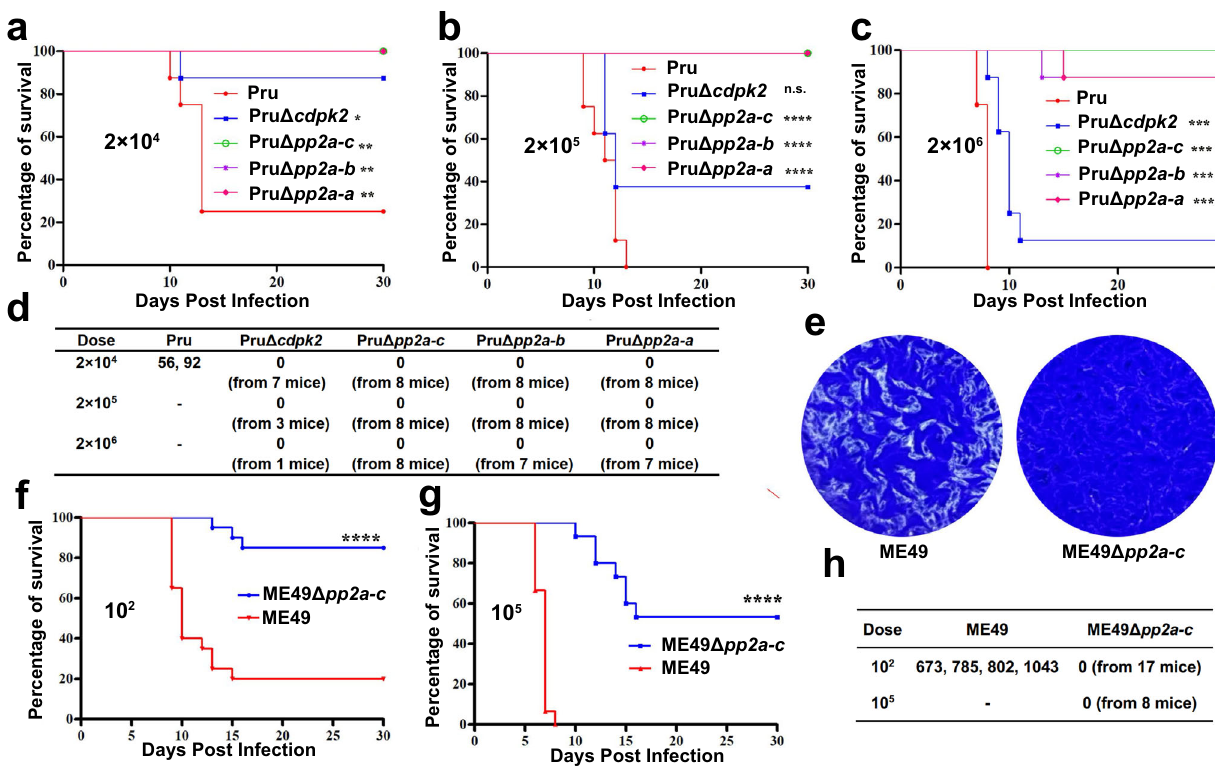
Fig. 4 | PP2A holoenzyme is necessary for formation of brain cysts in mice. a – c C57BL/6femalemicewereinfectedintraperitoneallywiththedesignateddoses oftheindicatedstrains( n =8mice/strain),andthesurvivalofmicewasmonitored for 30 days. Statistical signi fi cance tested by log rank Mantel-Cox test. Compared withPrustrain,for( a )group, *P value= 0.024(PruvsPru Δ cdpk2 ),** P value=0.003 (PruvsPru Δ pp2a-c ),** P value=0.003(PruvsPru Δ pp2a-b ),** P value=0.003(Pruvs Pru Δ pp2a-a );For( b )group,n.s.=notsigni fi cant,**** P value<0.0001;for( c )group, *** P value=0.0007(PruvsPru Δ cdpk2 ),*** P value=0.0002(PruvsPru Δ pp2a-c ),*** P value=0.0002 (Pru vs Pru Δ pp2a-b ), *** P value=0.0002 (Pru vs Pru Δ pp2a-a ). determined by FITC- Dolichos bi fl orus lectin (DBL) staining. Cyst burden was